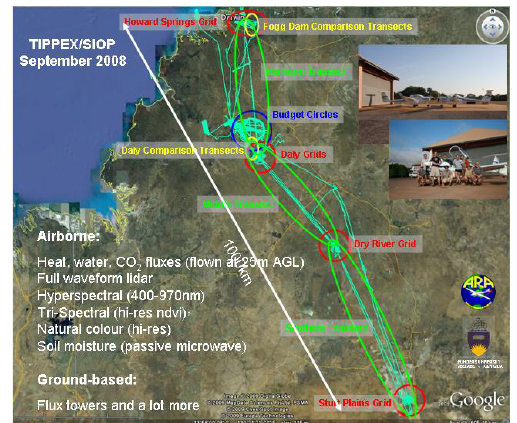
Figure 3: Flights along the NATT and other features of the TIPPEX sub-campaign of